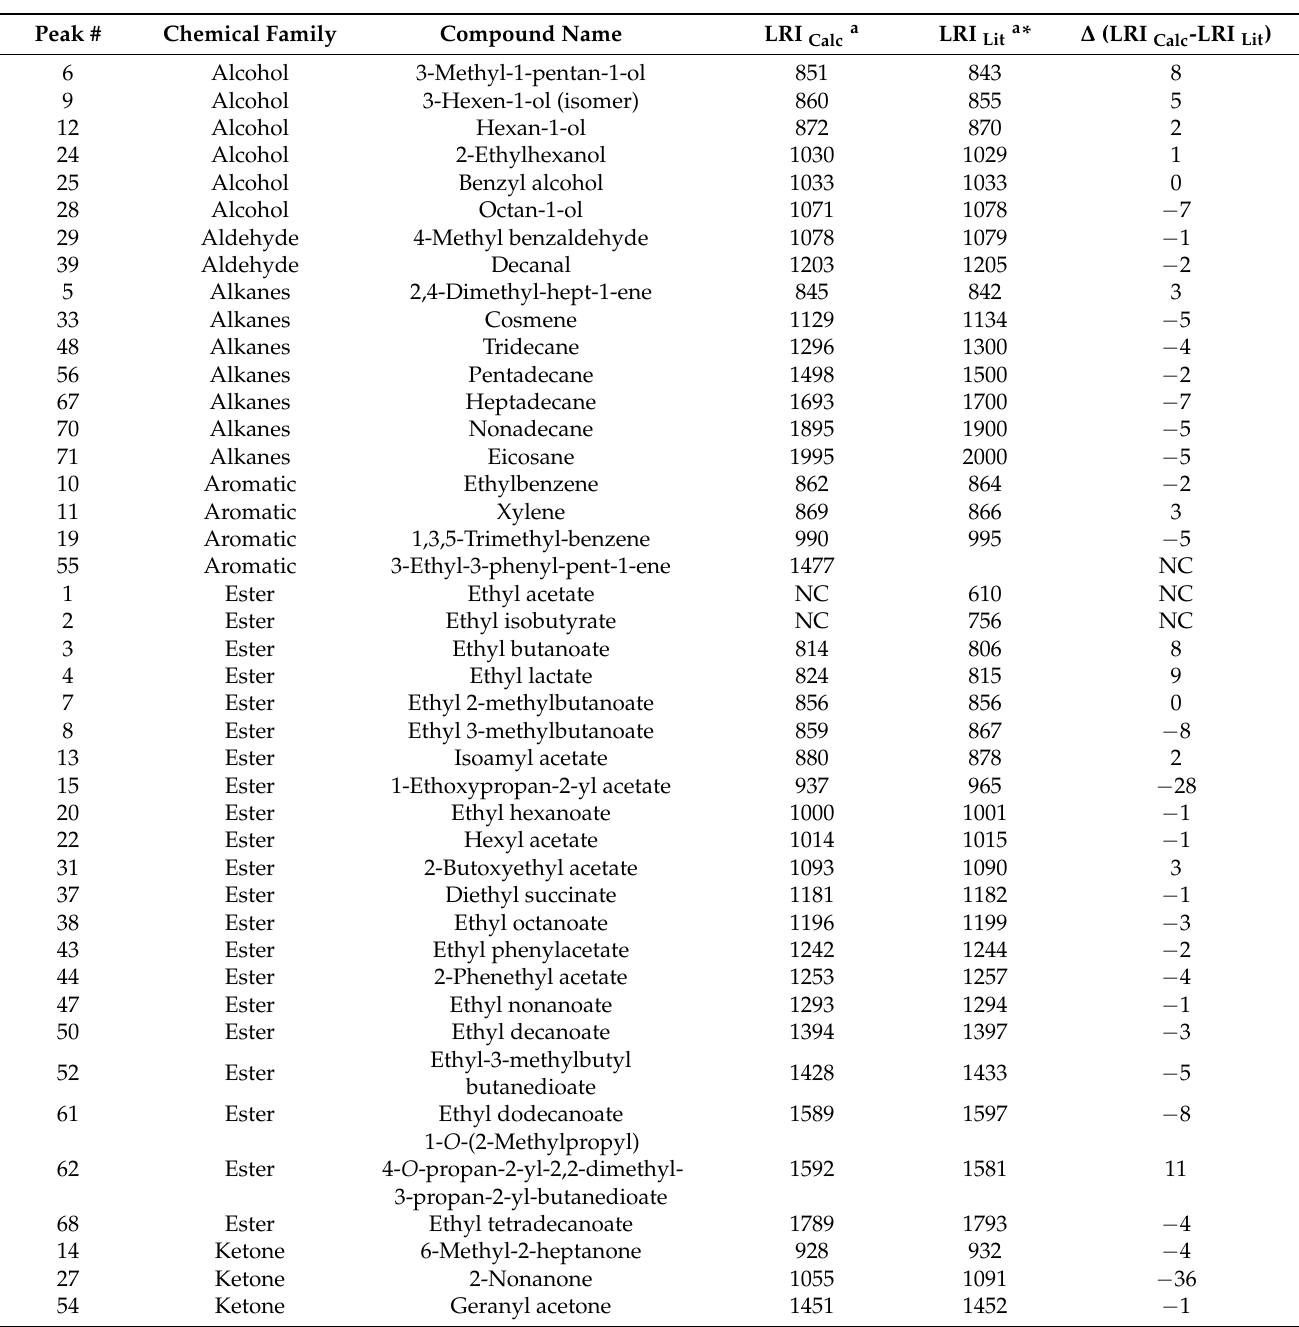
Table 2. VOCs tentatively identified in the samples under analysis by